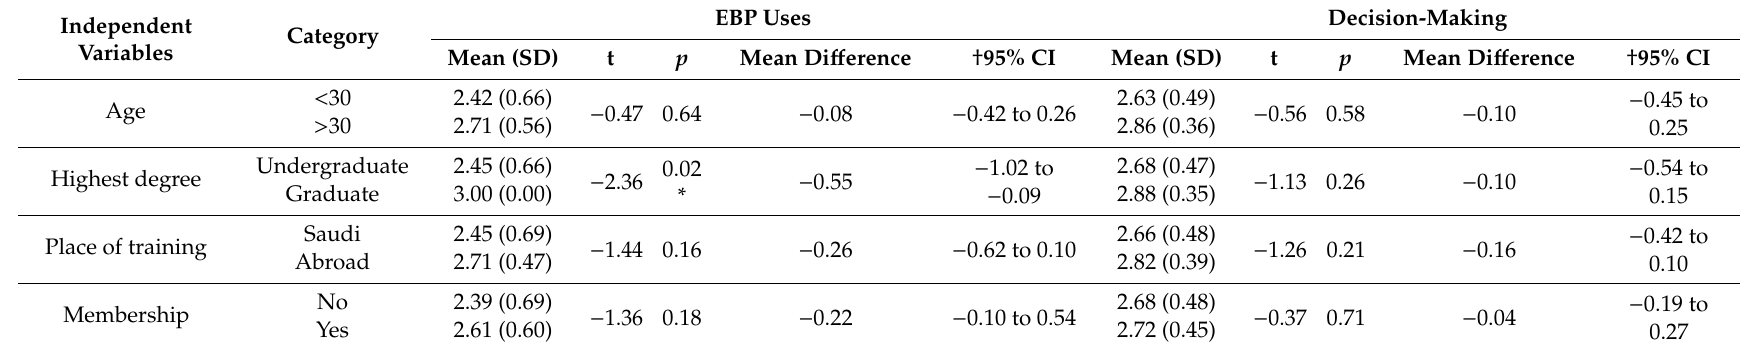
Table 4. Comparison of demographic characteristics and confidence with evidence-based practice (EBP) uses and clinical decision-making